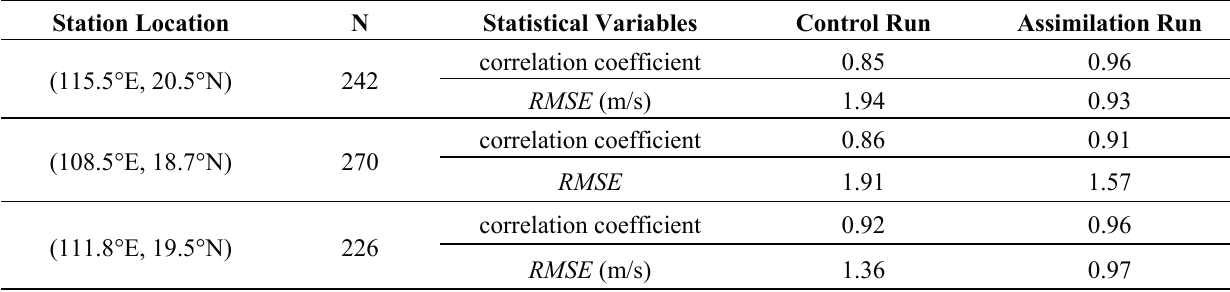
Table 7. Correlation coefficients and RMSE (m/s) calculated from control run and assimilation run with the ASCAT retrieval winds at ten points, respectively. N is the number of satellite samples at the location during